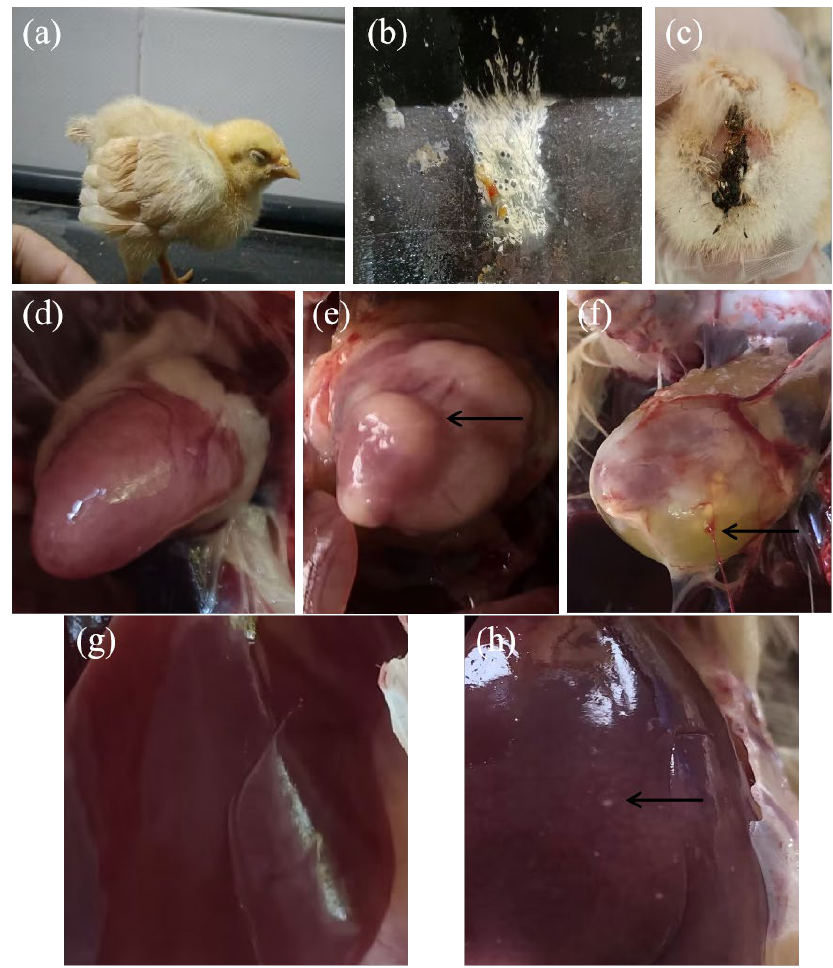
Figure 1. The clinical signs and gross lesions of the challenged birds observed. ( a ) Depression and poor growth; ( b ) diarrhea; ( c ) wet paste; ( d ) heart with no lesion; ( e ) heart with granuloma; ( f ) soft heart with pericardial effusion; ( g ) liver with no lesion; ( h ) pinpoint white foci of necrosis on liver surface.